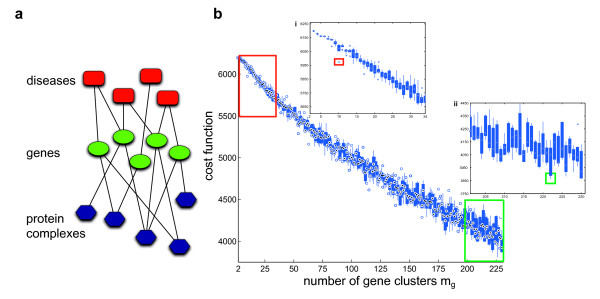
Decomposition of a gene-disease-protein complex network. We integrated the gene-disease network from [3] with human protein complexes from the CORUM database [16]. This resulted in a layered tripartite graph, which is schematically drawn in (a). We performed a 10-fold approximation of this graph to estimate appropriate numbers of clusters. The boxplot curve (b) shows how the cost function f(H, C) from equation (1) depends on the number of gene clusters mg. The true minima of the cost function are decreasing with mg, and this is also visible in the approximated minima using our proposed algorithm. Therefore, we are able to identify structures on various resolution levels. The details represent the cost function course for large-scale clustering (i) and a decomposition on small scale (ii), respectively. For our detailed analyses, we used the decompositions showing steep drops in the cost function marked by the red and green boxes.